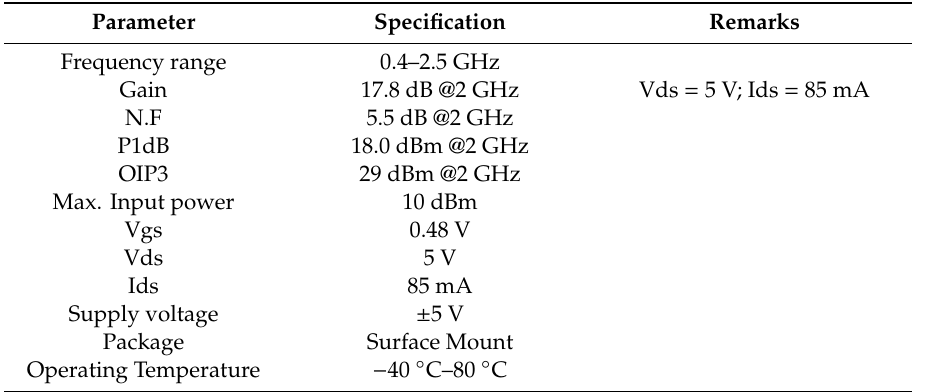
Table 4. High-power amplifier S parameters at the S band.